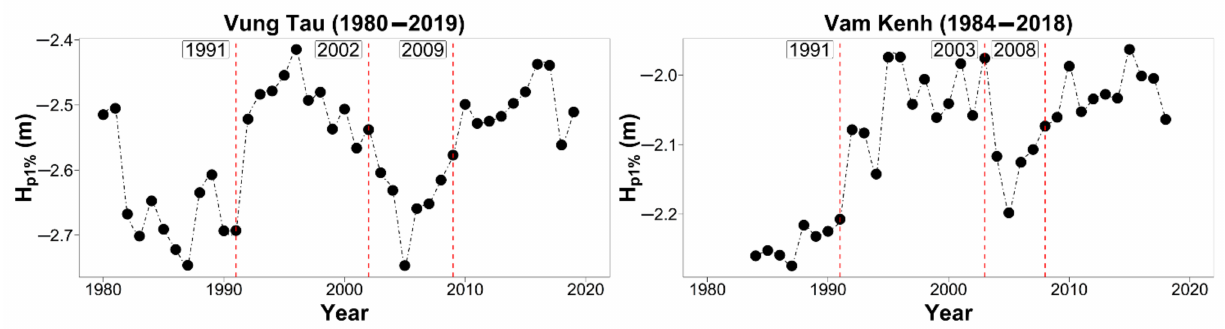
Figure A5. Changepoint years showing the possible shifts in H p1% .